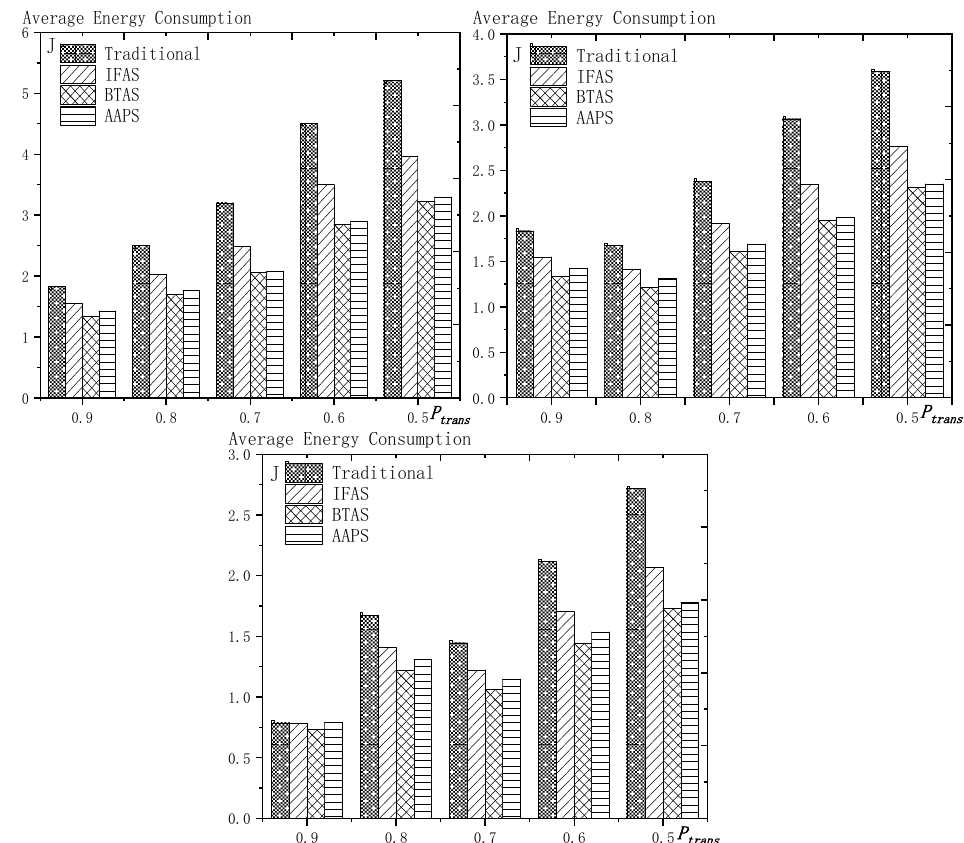
Figure 25. The average energy consumption with P trans as variable (setting 1, setting 2, setting 3). Table 16. The improvement of energy consumption compared with the traditional algorithm.